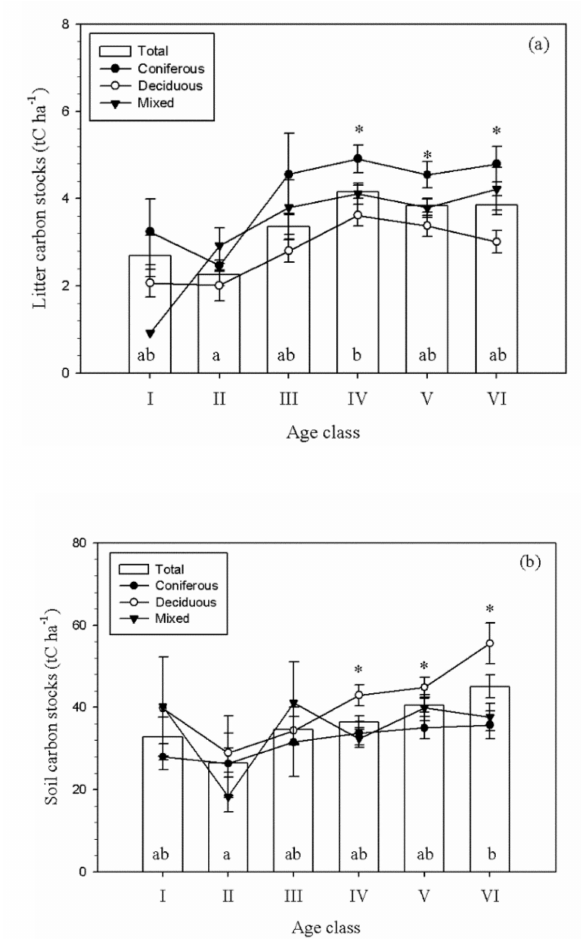
Figure 3. Litter ( a ) and soil at 0–30 cm ( b ) carbon stock by age class and forest type in South Korea. The error bars represent the standard error of the mean. Di ff erent letters in the bars indicate significant di ff erences among age class ( p < 0.05). Significant di ff erences between forest type in a same age class are indicated by asterisks ( p <